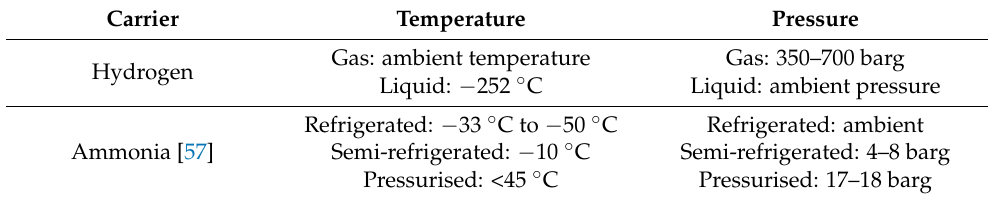
Table 2. Typical storage conditions of ammonia and